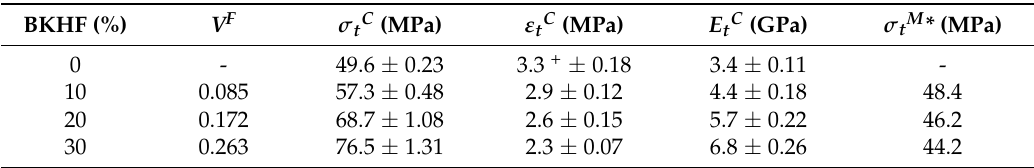
Table 1. Tensile strength, strain at break, and Young’s modulus of the composite. Contribution of the matrix to the tensile strength of the composite. BKHF